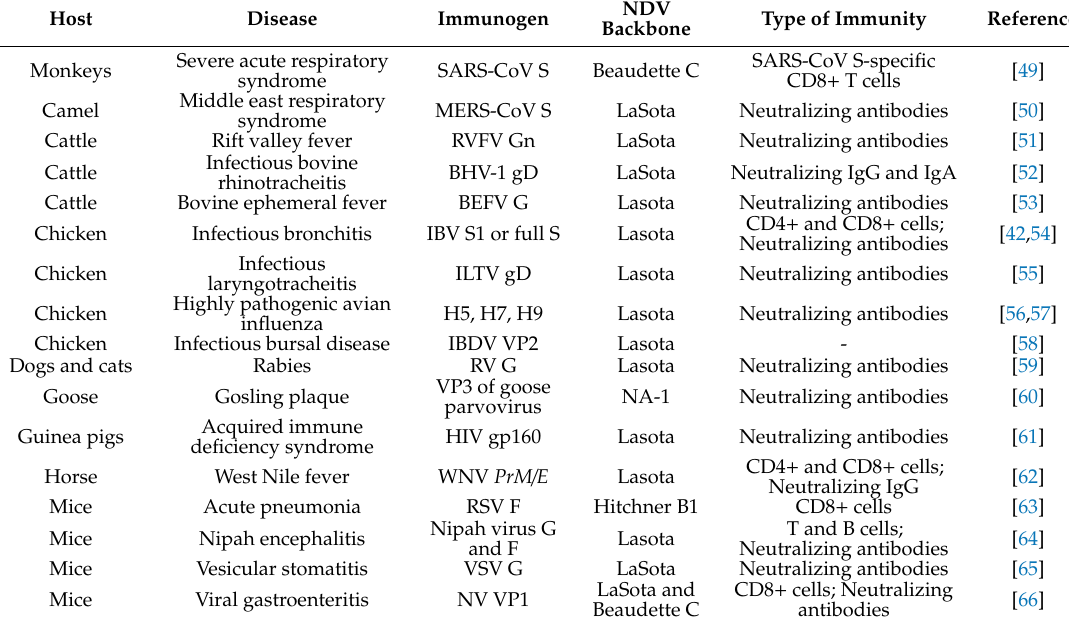
Table 1. NDV as an e ff ective vaccine vector in various animal